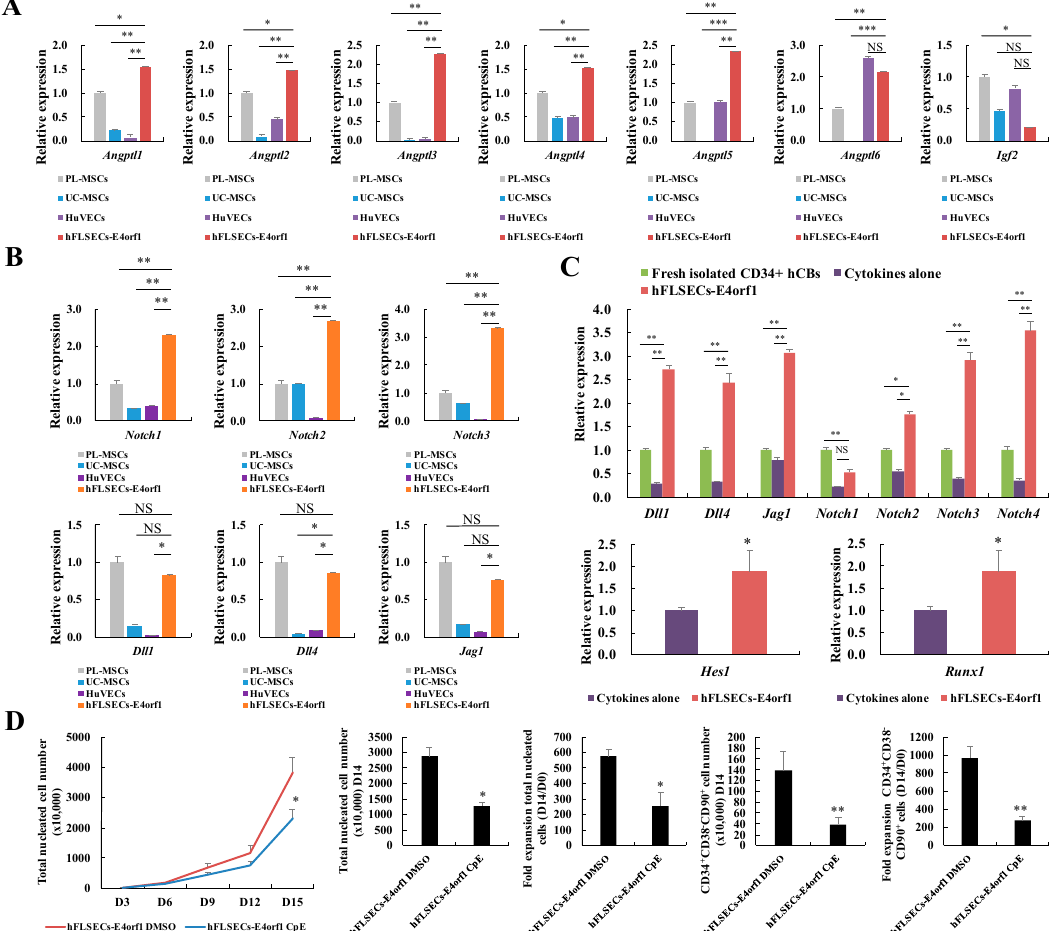
Figure 5. Hematopoietic-related cytokines and Notch signaling molecules contribute to supportive effect of hFLSECs-E4orf1. ( A ) hFLSECs-E4orf1 express growth factors that support HSC expansion. Comparison of the relative transcript levels of hematopoietic-related genes in hFLSECs-E4orf1, with PL-MSC, UC-MSCs, and HuVECs as controls. ( B ) Comparison of the relative transcript levels of Notch genes in hFLSECs-E4orf1, with PL-MSCs, UC-MSCs, and HuVECs as controls. ( C ) Notch signaling pathways are compared among freshly isolated CD34 + hCB cells, CD34 + hCB cells in cytokines alone and those cocultured with hFLSECs-E4orf1 at day 14 (upper panel). The expression of Notch target genes ( Hes1 , Runx1 ) are compared between CD34 + hCB cells in cytokines alone culture and those cocultured with hFLSECs-E4orf1 at day 14 (lower panel). ( D ) Inhibition of Notch signaling influences the effect of hFLSECs-E4orf1 on HSPC expansion. Data represented as mean ± SEM. NS means “no significant difference”. * p < 0.05, ** p < 0.01, *** p < 0.001.